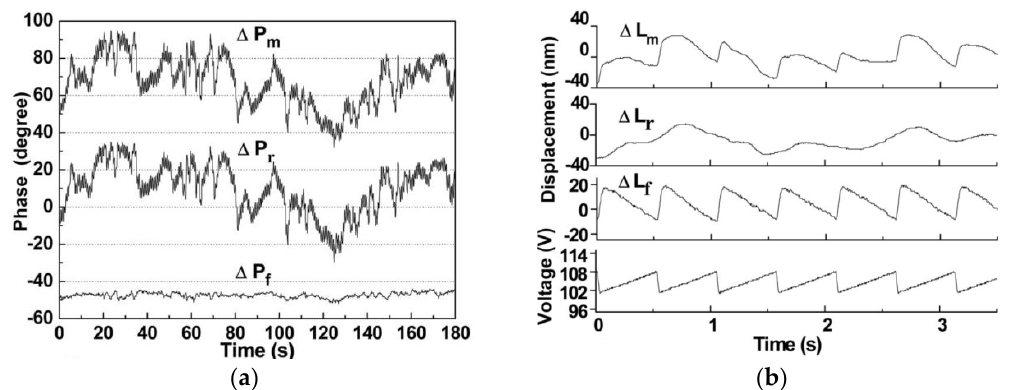
Figure 6. Results of the displacement measurement: ( a ) phase stability test results, and ( b ) measurement result of PZT vibration. The bottom curve shows the PZT driving signal. (Figure reproduced from Ref. [13]).